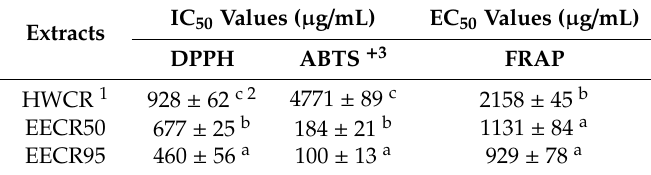
Table 6. The antioxidant activity of hot water, 50 and 95% ethanol extracts of C. cajan